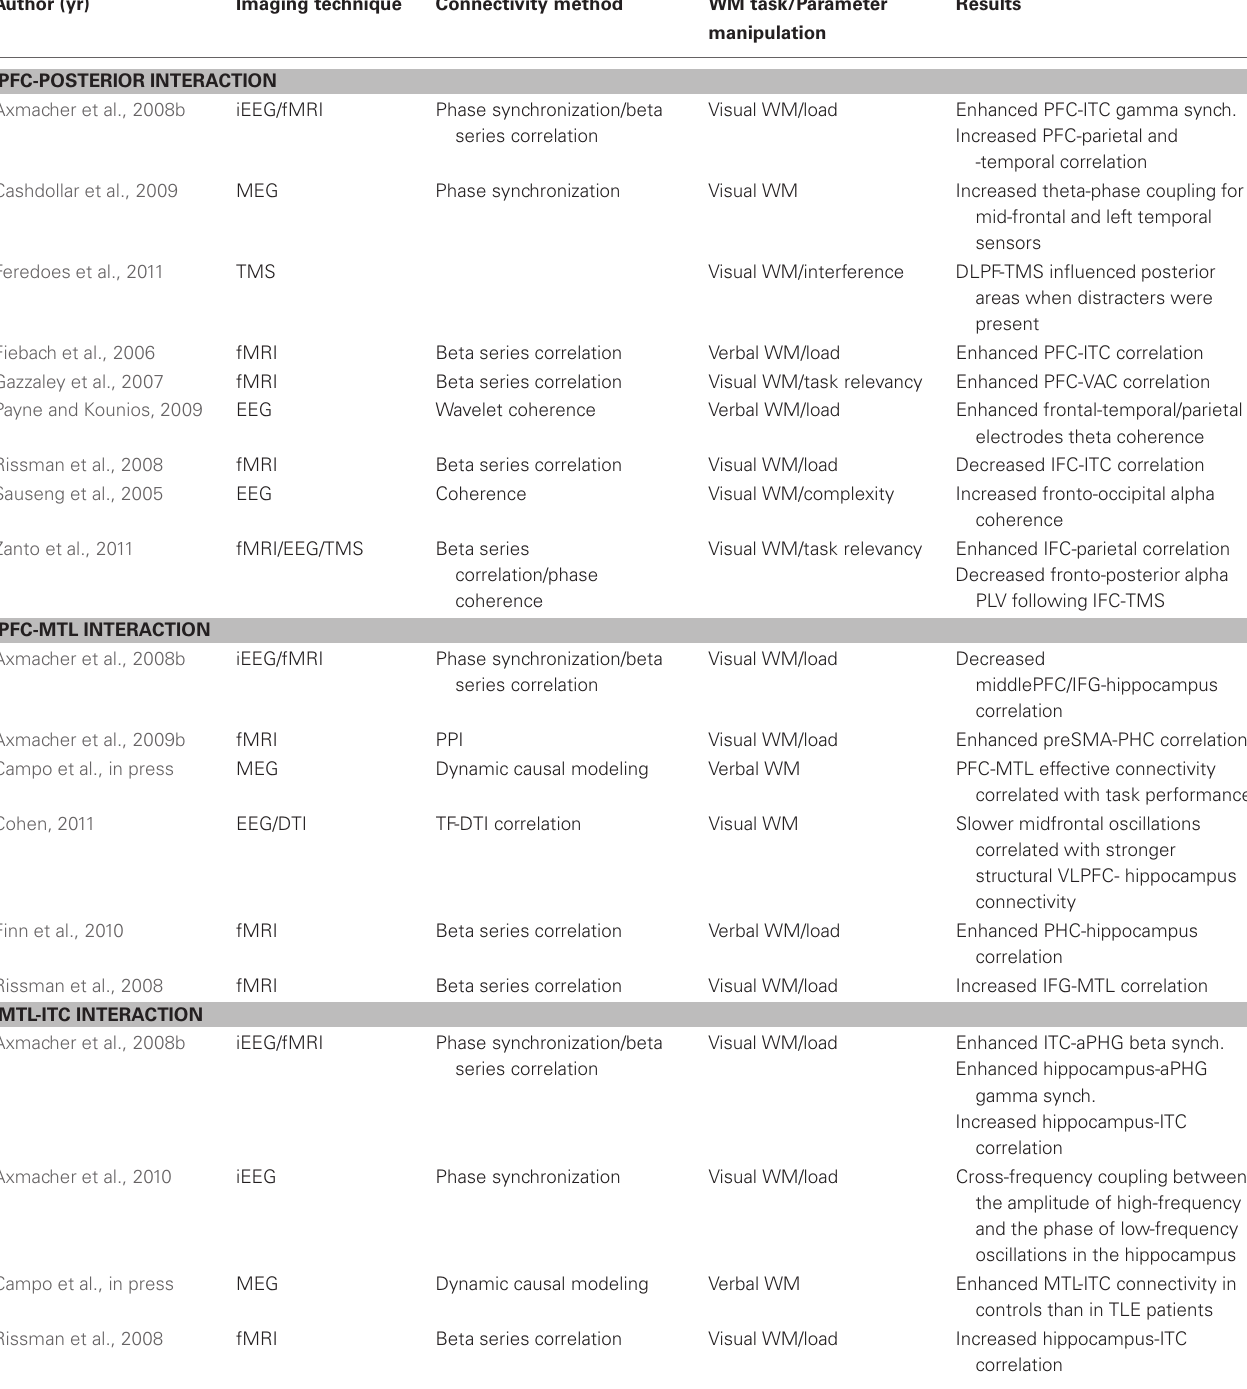
Table 1 | Results from studies showing modulation among PFC-MTL-posterior cortex during the performance of a WM task as a function of parametric manipulation of mnemonic